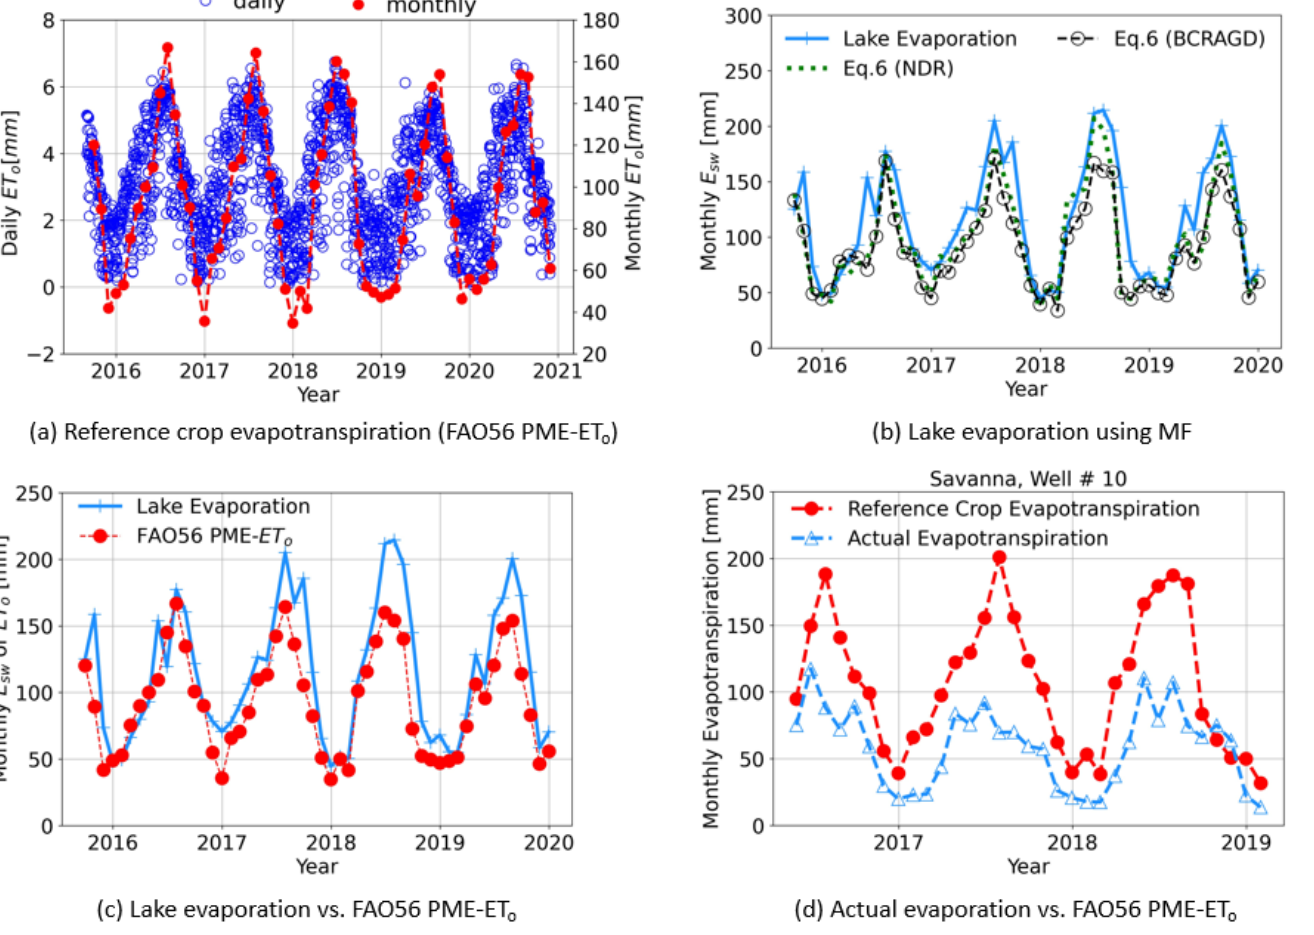
Figure 3. Computed ET o and E sw and measured E sw and ET a